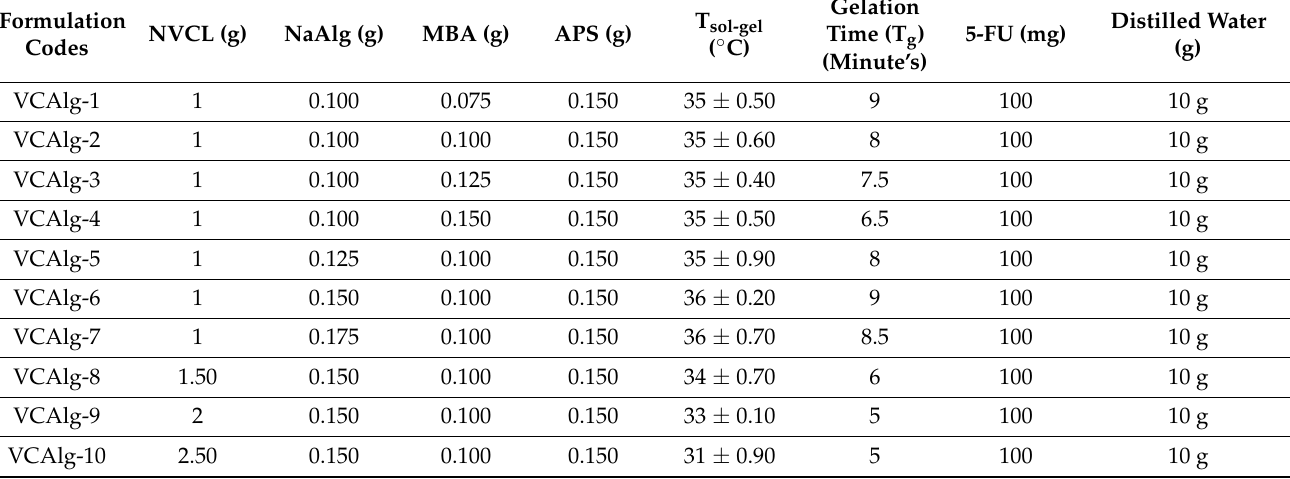
Table 1. Feed composition of chemically grafted thermoresponsive Poly (NVCL-g-NaAlg) in situ depot